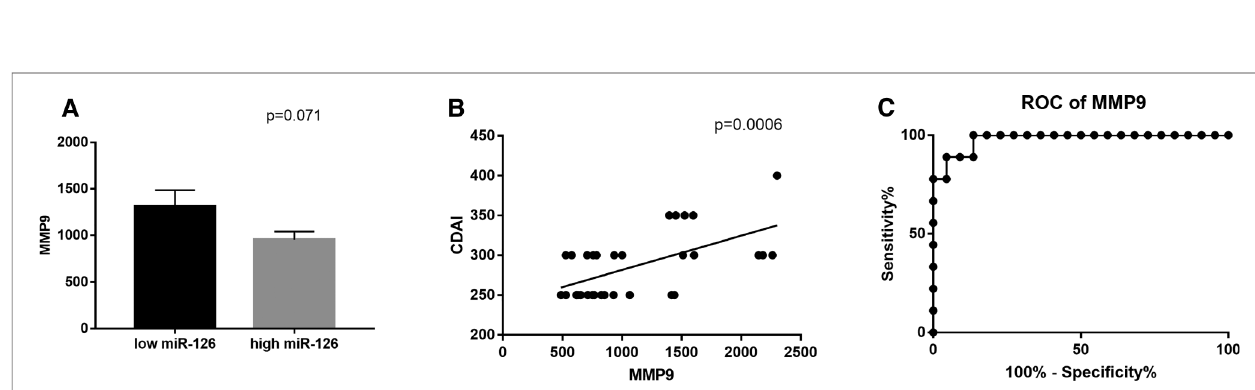
FIGURE 3 | ( A ) Correlation between circulating MMP9 and miR-126 expression and ( B ) with CDAI scores. ( C ) Receiver operating characteristics (ROC) curve for the ability of circulating MMP9 to discriminate between CD patients with or without intra-abdominal fi stulas: Area Under Curve (AUC) 0.9798, sensitivity 88.89 and speci fi city 95.45, p